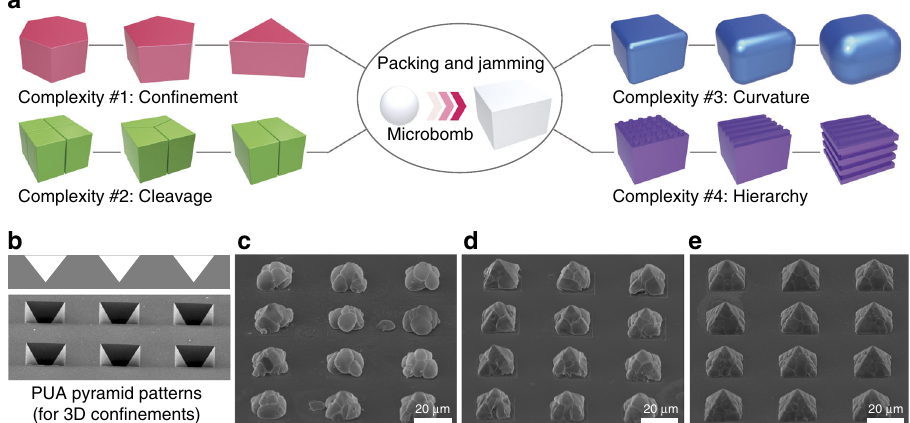
Fig. 7 Topographical complexity of micro-clusters. a Illustration of the topographical complexity of the clusters as a result of the boundary shapes, the cleavages, the edge pro fi les, and the hierarchy. b – e Exemplary SEM images of the inverse pyramidal con fi nement and three-dimensional clusters formed within